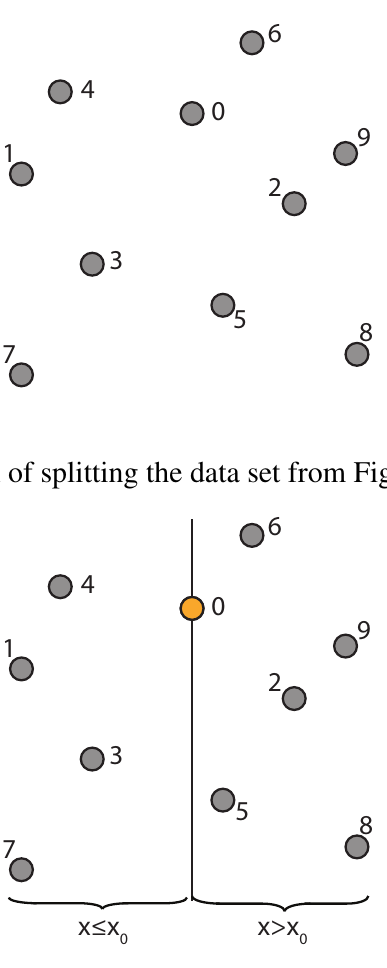
Figure 4. This is equivalent to running a splitting hyper-plane through the median Node 0 according to the x-axis. Figure 3. A collection of points in two-dimensional space.